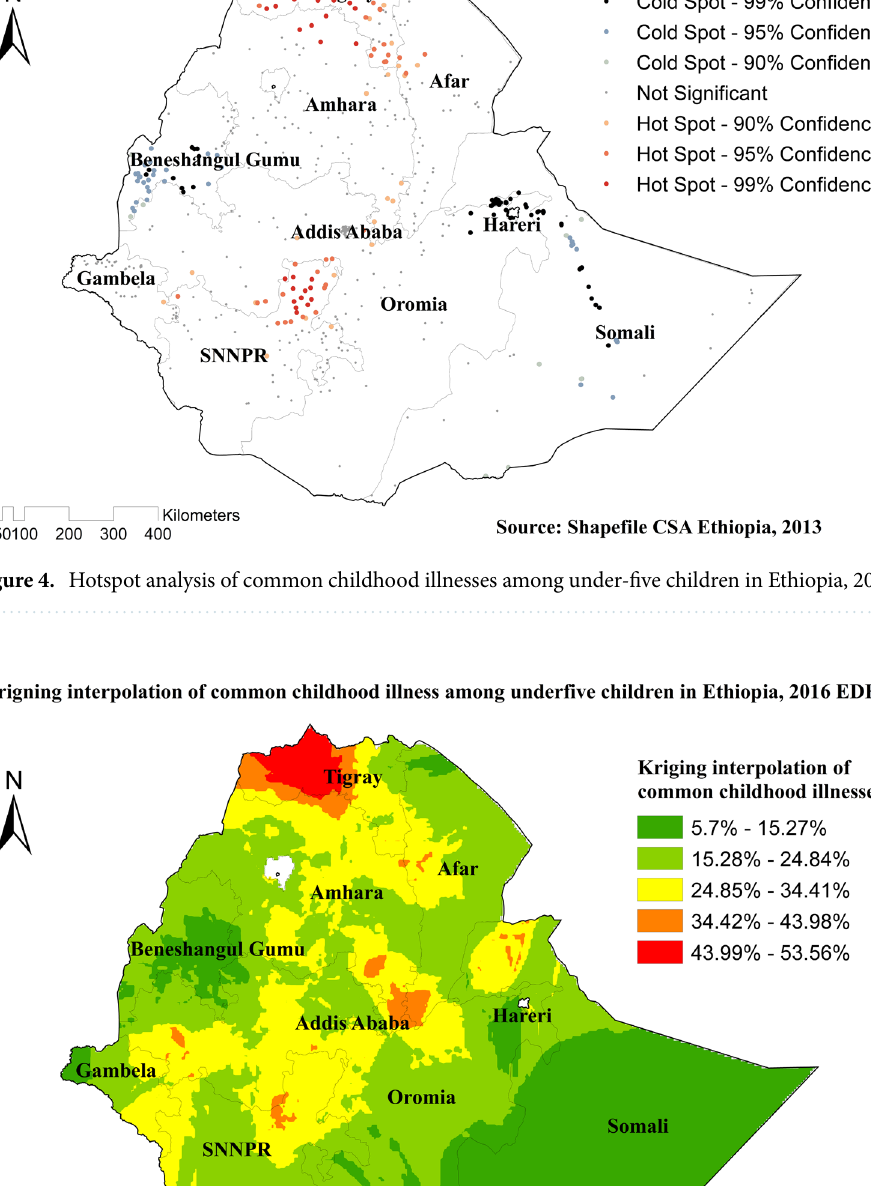
The odds of common childhood illnesses were lower among children from families with high household wealth, and this was consistent with previous findings in low-income to middle-income countries 32–35 . Besides, high community poverty increased the odds of common childhood illnesses in Ethiopia. The possible explana- tion might be that poverty is strongly associated with food insecurity, living standard, and housing conditions which could greatly affect the well-being of a child. Hence children from households and communities with low